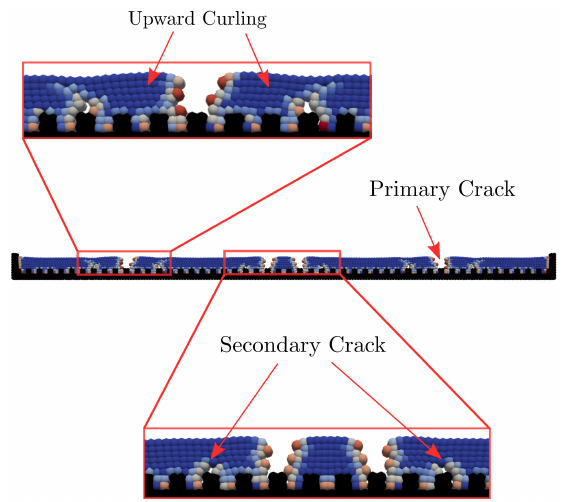
Figure 5. Zoom-in view of the cracks. Note: The deformation is amplified by a factor of 20 for clarity.